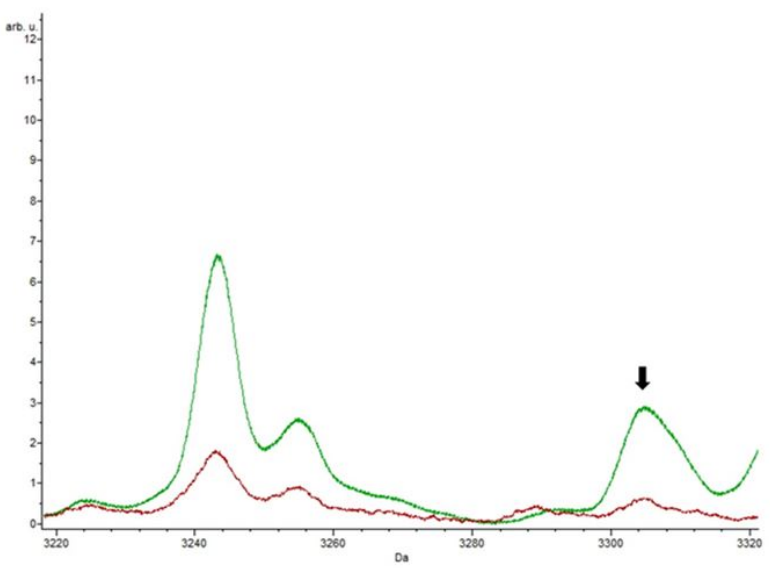
Figure 6. The red spectrum represents the control, and the green spectrum was obtained by the action of ampicillin. The arrow shows the peak at m/z 3304.92 that was only detected in the presence of the antibiotic.